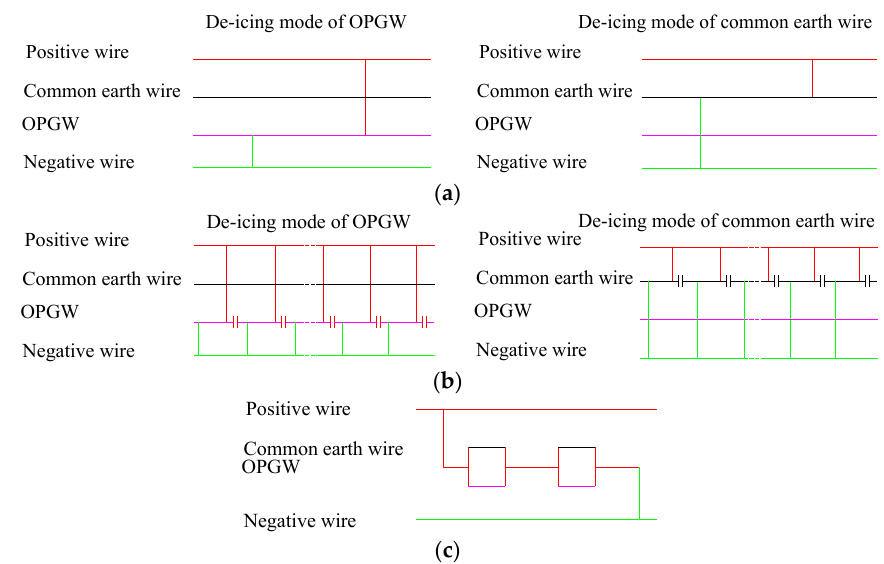
Figure 1. DC de-icing circuit: ( a ) Connection Mode 1; ( b ) Connection Mode 2; ( c ) Connection Mode 3.